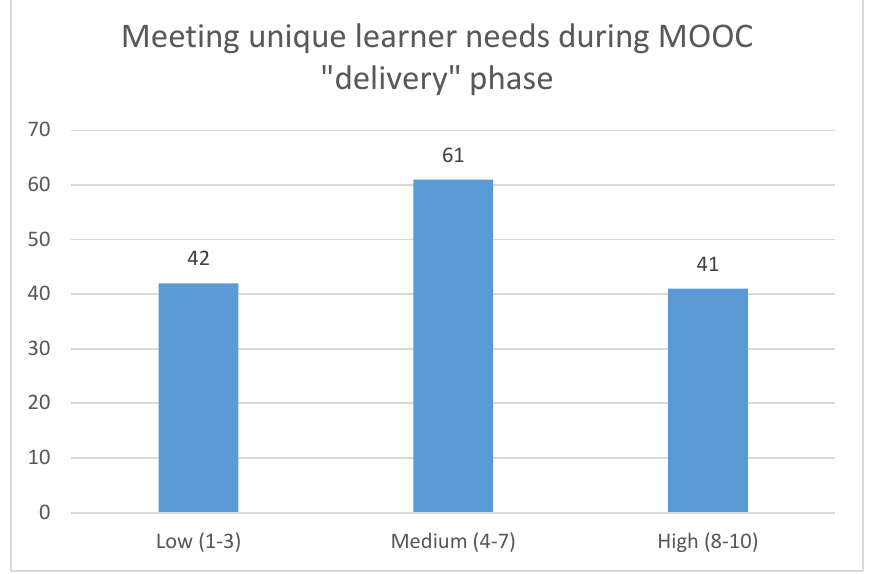
Figure 4. Effort placed on meeting unique learner needs when delivering most recent MOOC. Note: on a scale of 1 (low) to 10 (high)